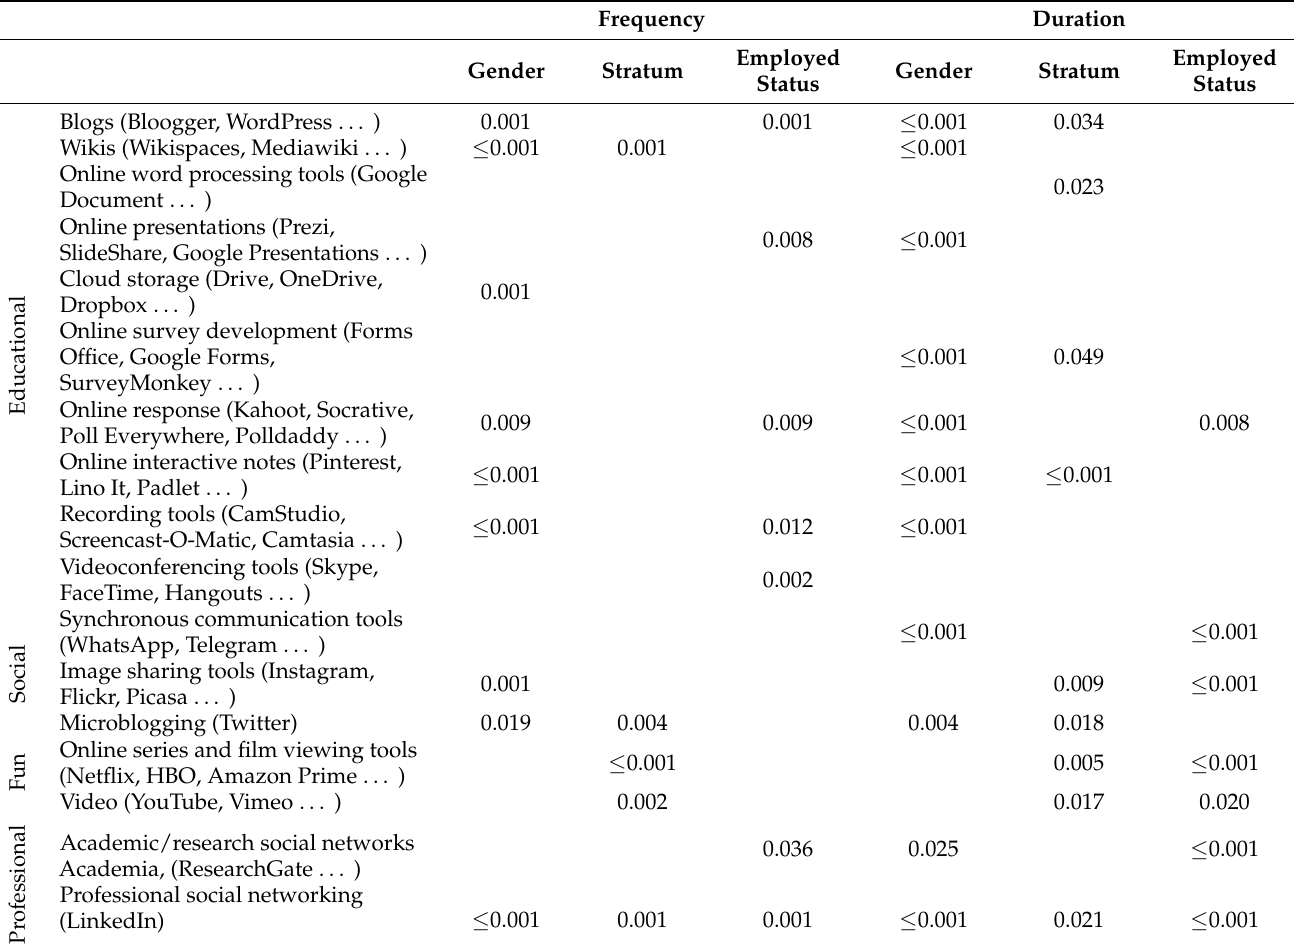
Table 2. Pearson’s chi-squared test. Frequency Duration Employed Gender Stratum Gender Stratum Status